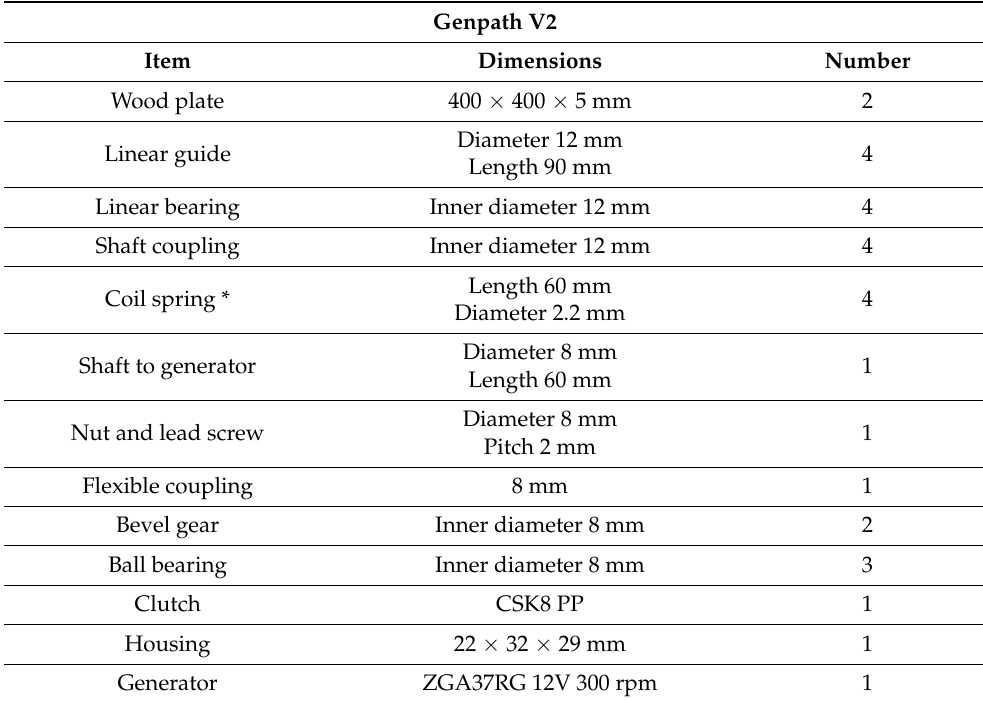
Table 5. Parameter of Genpath V2.